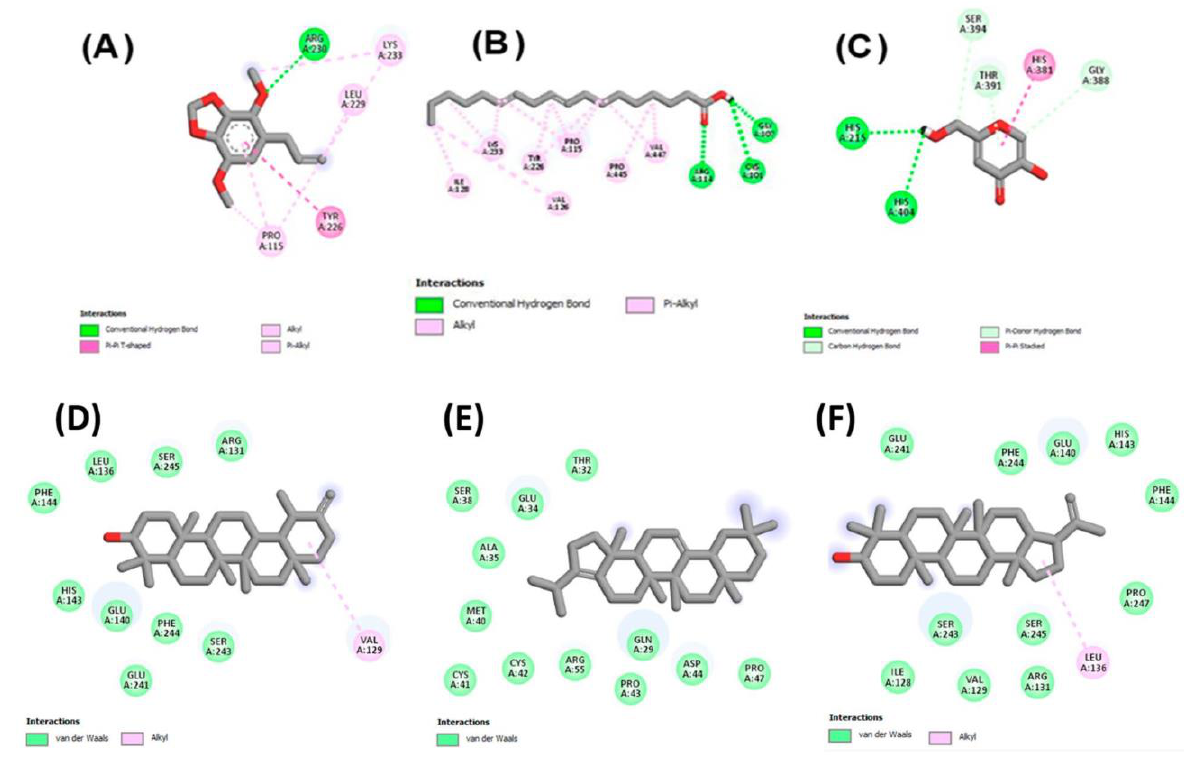
Figure 4. Interactions of tyrosinase active site residues with ( A ) apiol, ( B ) octadecadienoic acid, ( C ) kojic acid, ( D ) taraxasterol, ( E ) a-neooleana-3(5), 12-dien, ( F ) hopa-22(29)-ene-3alpha-ol.